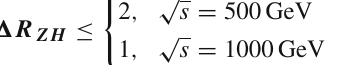
Table 6 Event selection efficiencies corresponding to a,b) signal and c,d) background processes assuming different benchmark scenarios at the center-of-mass energies of 500 and 1000 GeV √ s = 500 GeV